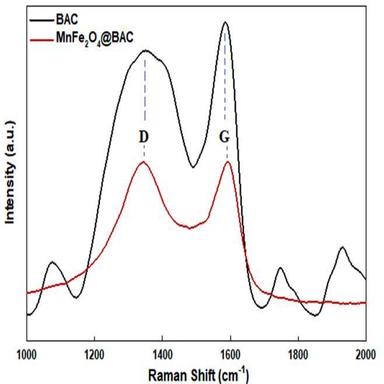
Raman spectra of BAC and MnFe2O4@BAC.